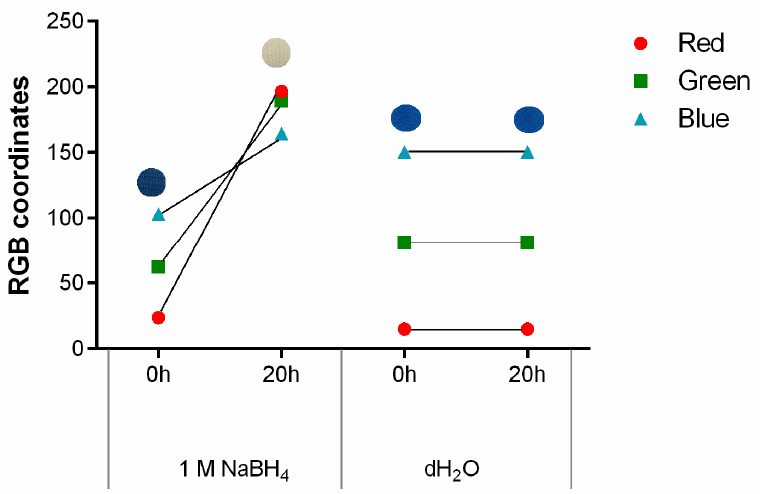
Figure 4. The g/L, after exposure to 1 M NaBH4, as a reducing agent, and distilled water, as a control, for 20 h, (n = 3, ±SD).